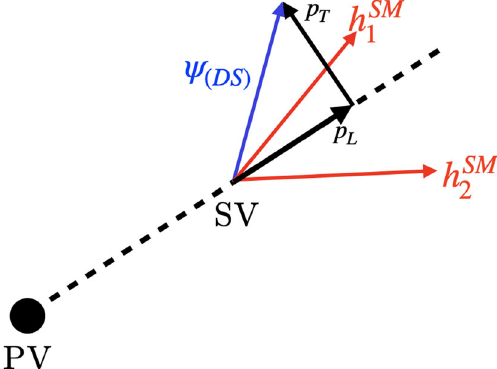
Fig. 1 Determination of p miss B + → ψ DS Λ c ( 2595 ) + channel, where more objects are present in the final state, the computation would be analogous. In the figure, PV (SV) representtheprimary(secondary)vertices,i.e.,the b -hadronproduction (decay)